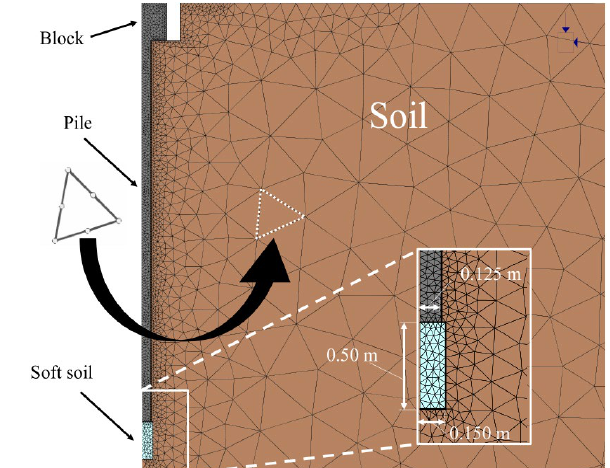
Figure 4. Numerical model for validation and detail of the soft material region inserted below the pile toe and graded mesh type and 6-noded triangle